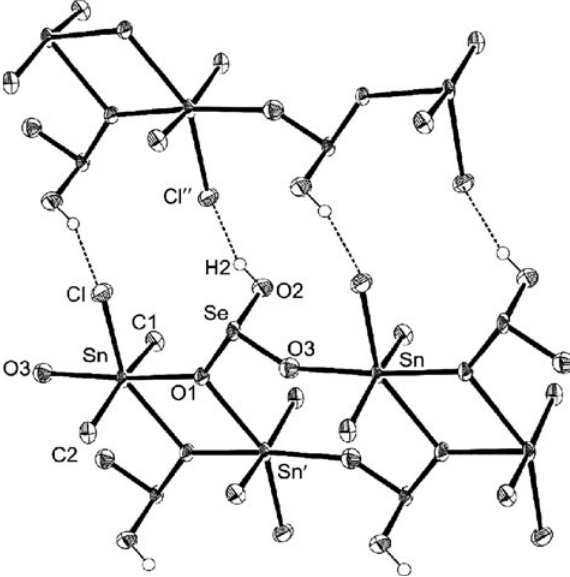
Figure 1 Selected bond lengths and angles Sn-C(1) 2.097(7); Sn-C(2) 2.099(7); Sn-O(1) 2.235(5); Sn-O(1 ′ ) 2.546(5); Sn-O(3) 2.285(6); Sn-Cl 2.534(2) Å ; C(1)-Sn-C(2) 167.0(4);